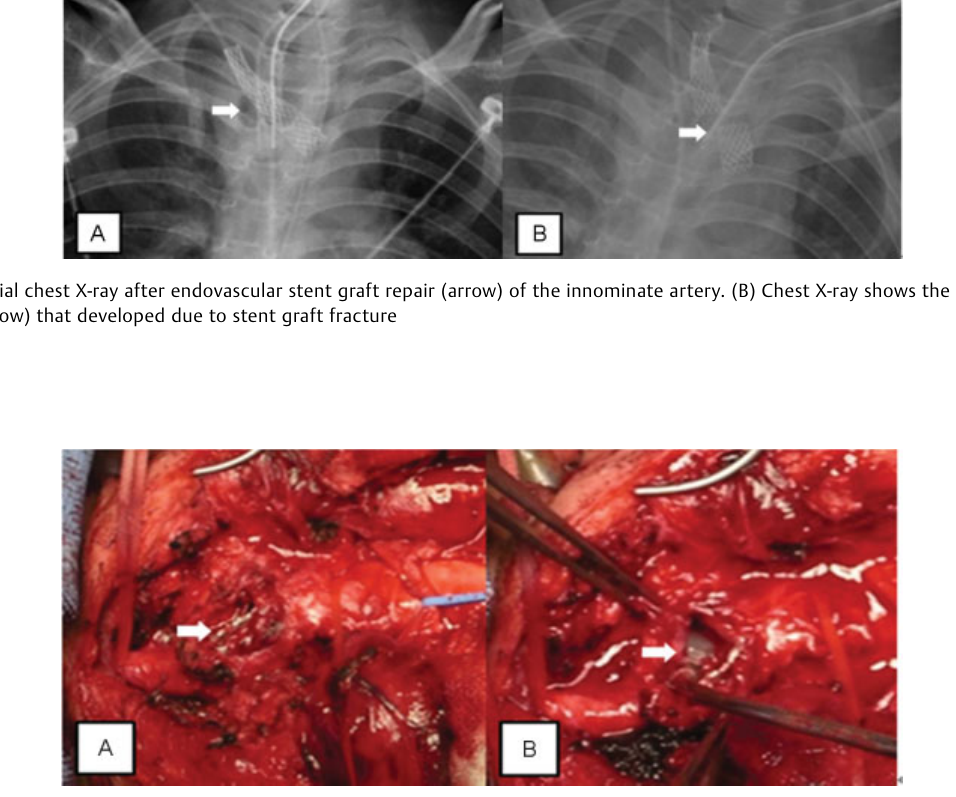
Fig. 2 (A) The endovascular stent fragments (arrow) could be seen through a tear in the innominate artery. (B) After placing the innominate artery laterally, the endotracheal tube (arrow) could be seen through the fi stula in